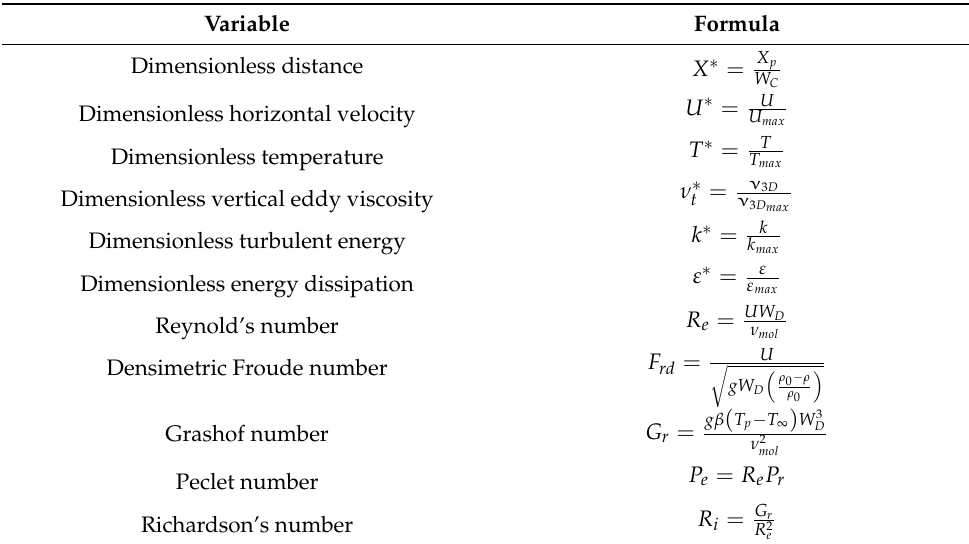
Table 7. Definitions of dimensionless